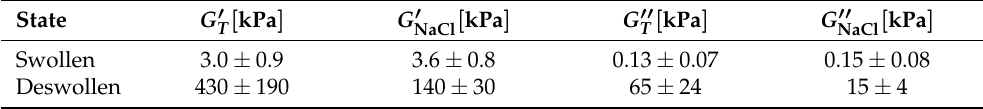
Table 2. The storage and loss moduli for gels, either deswollen by temperature (indexed T ) or salt (indexed NaCl). The data for G (cid:48) and G (cid:48)(cid:48) are from the batches from the previous study. The swollen T T state was measured at T = 20°C and c NaCl = 0molL − 1 and the deswollen state at T = 40°C and c NaCl = 0molL − 1 . G (cid:48) and G (cid:48)(cid:48) are from a new batch. The swollen state was measured at NaCl NaCl T = 20°C and c NaCl = 0molL − 1 and the deswollen state at T = 20°C and c NaCl = 1molL − 1 .